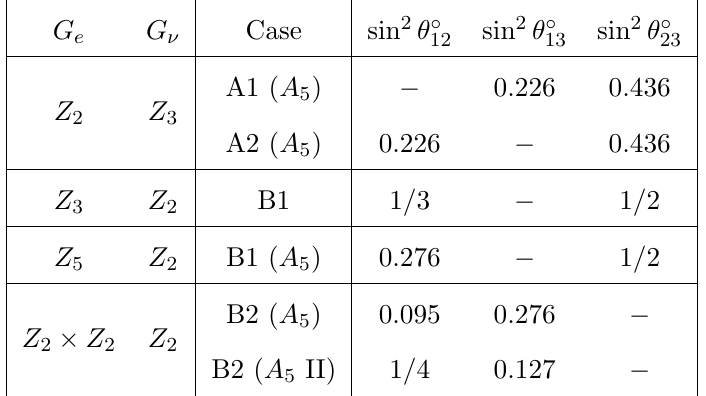
Table 6 . Values of the (cid:12)xed parameters sin 2 (cid:18) (cid:14) to the residual symmetries G e and G (cid:23) , as derived in ref. [20] (see also ref. [21]). The entries marked with \ " are not (cid:0)